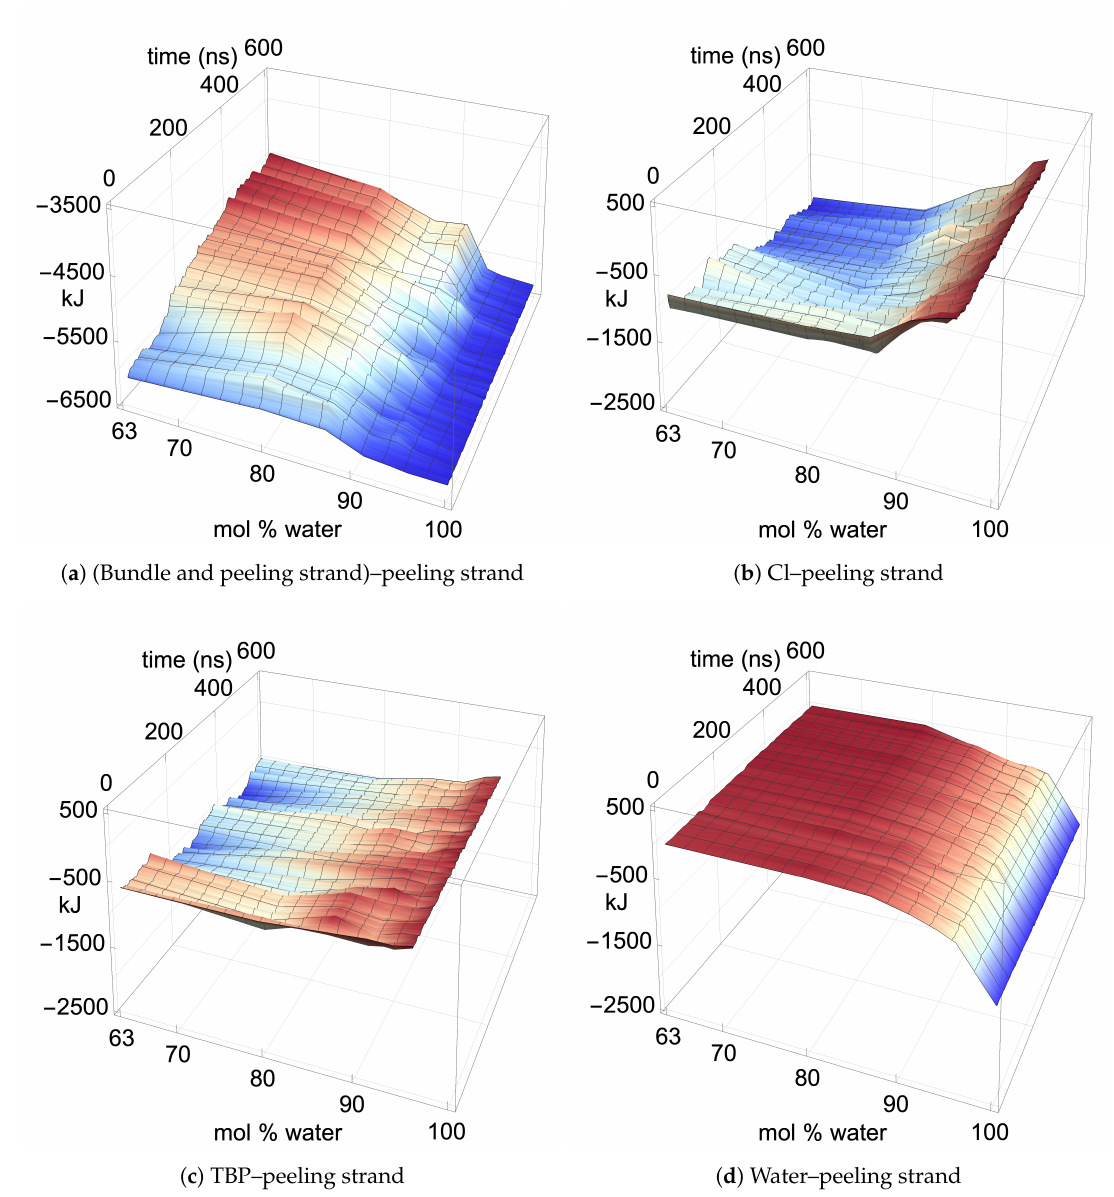
Figure 11. The pairwise energies for the first yellow separating strand at 360K. The pairwise energies are shown between the following: ( a ) (bundle–peeling strand and peeling strand)–peeling strand (i.e., within the strand and with the rest of the cellulose bundle); ( b ) Cl–peeling strand; ( c ) TBP–peeling strand; ( d ) Water–peeling strand. These data represent the first yellow strand to peel or the non–peeling yellow strand if no yellow strands peeled in the simulation. The data were averaged over 1000 data points, using a rolling average. Every 100th point was then plotted to maintain plot clarity